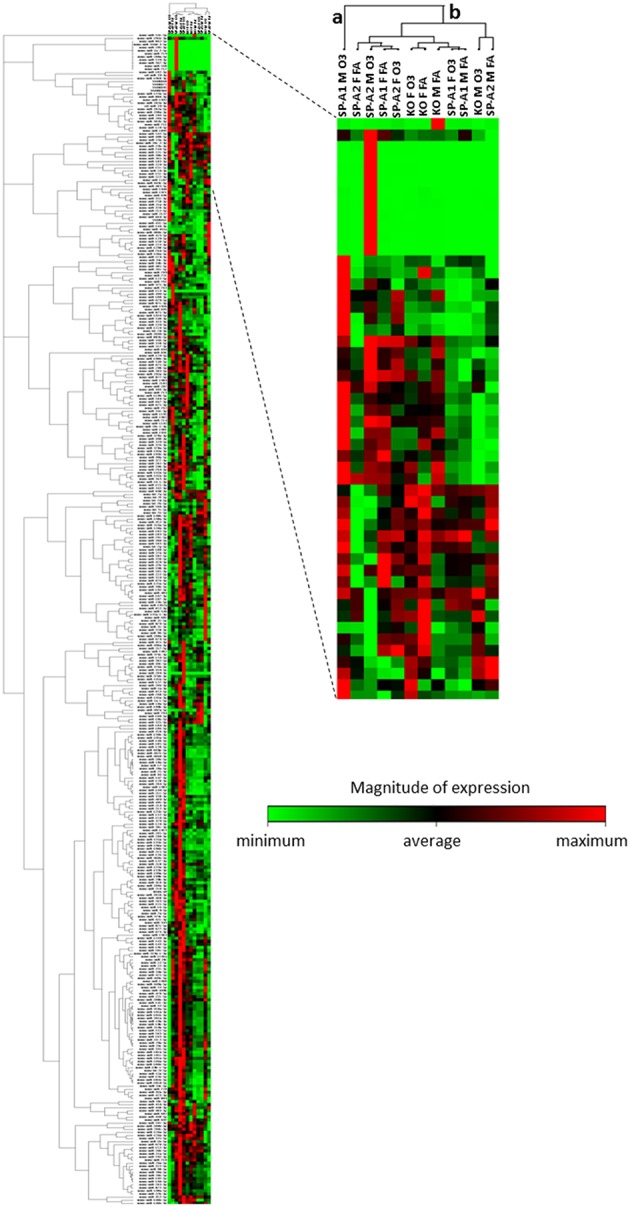
Heat map and dendrogram that shows a graphical representation of the fold regulation of miRNome expression between our different experimental groups and a non-supervised hierarchical clustering of these groups into clusters indicating co-regulated miRNAs across groups or individual samples. Cluster “a” consist only of the SP-A1M O3 group and cluster “b” contains all other groups studied. The colored bar indicates the magnitude of expression of each miRNA in each group.